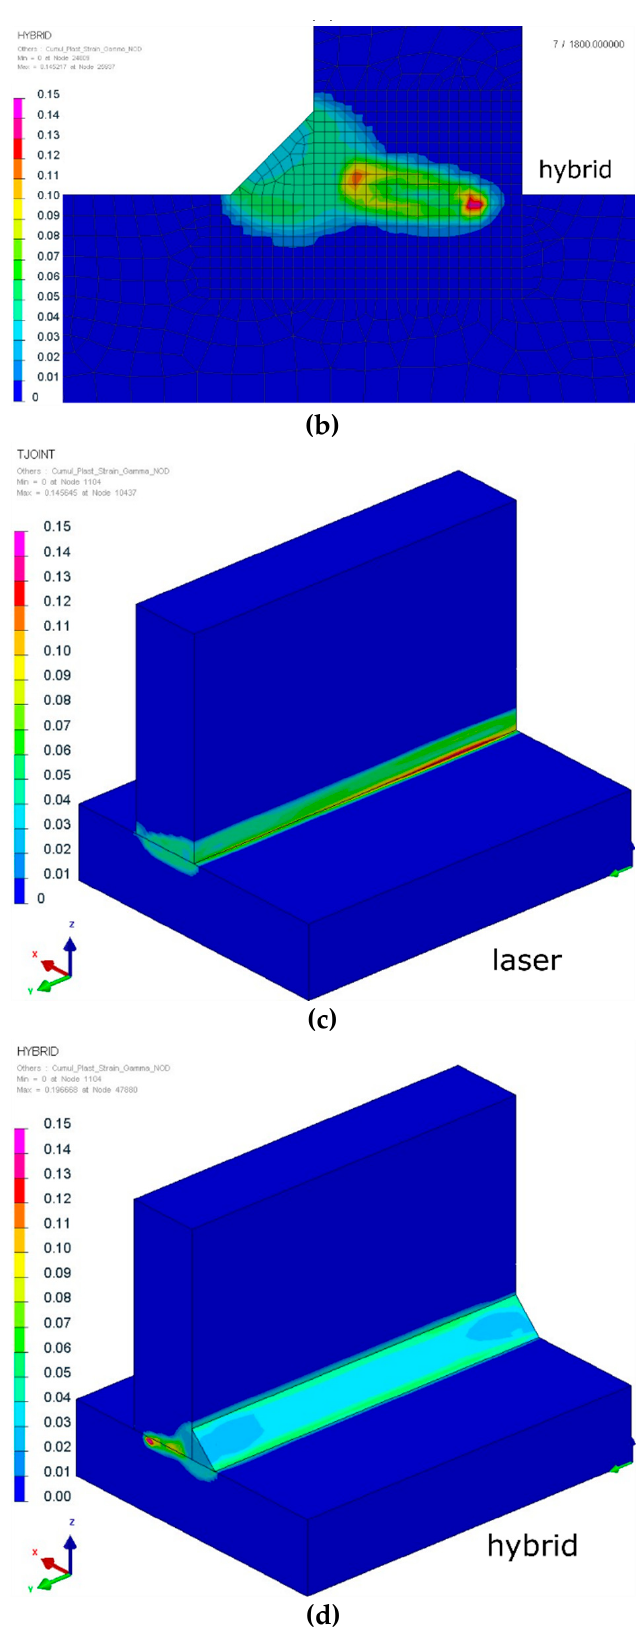
Figure 12. Cumulative plastic strains of the ( a , c ) laser and ( b , d ) hybrid welded S700MC steel T-joints with a thickness of 10 mm (cross-sections were made in the half-length of the joint).